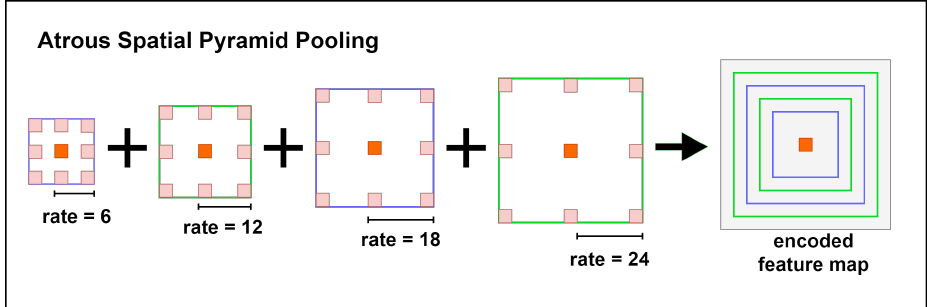
Figure 3. This is Atrous Spatial Pyramid Pooling (ASPP). The kernel of each convolution block is 3 × 3. The final encoded feature map concatenates multiple parallel filters with different rates, which are shown as the outer colorful